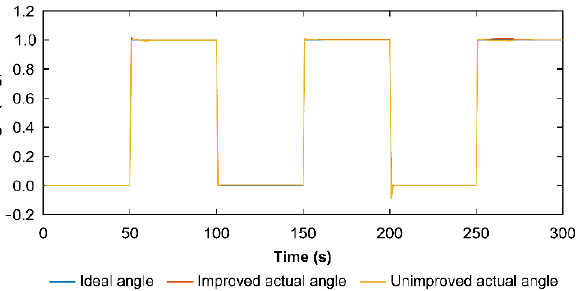
Machines 2022 , 11 , 5 Figure 15. Roll axis decoupling front and rear angular position tracking curve. Figure 15. Roll axis decoupling front and rear angular position tracking curve. Figure 15. Roll axis decoupling front and rear angular position tracking curve. Figure 15. Roll axis decoupling front and rear angular position tracking curve.